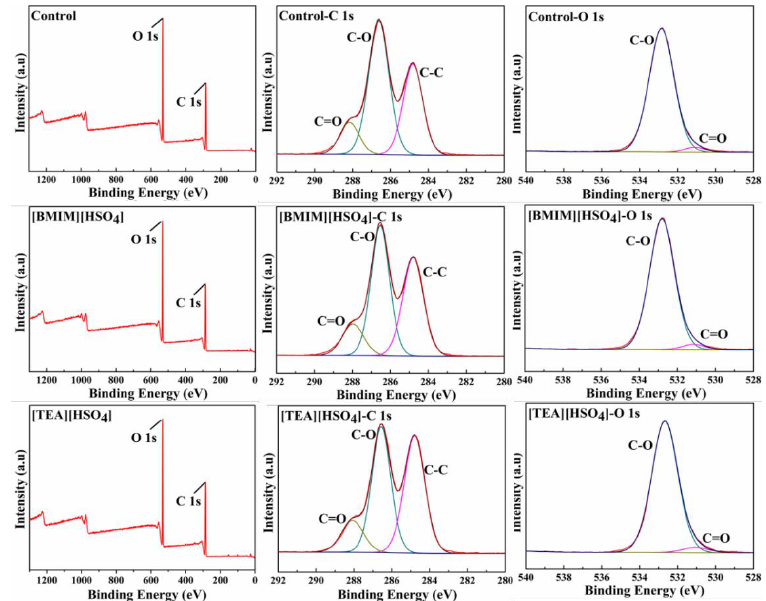
Figure 2. XPS analysis of oxygen-delignificated kraft pulps with or without IL pretreatments.